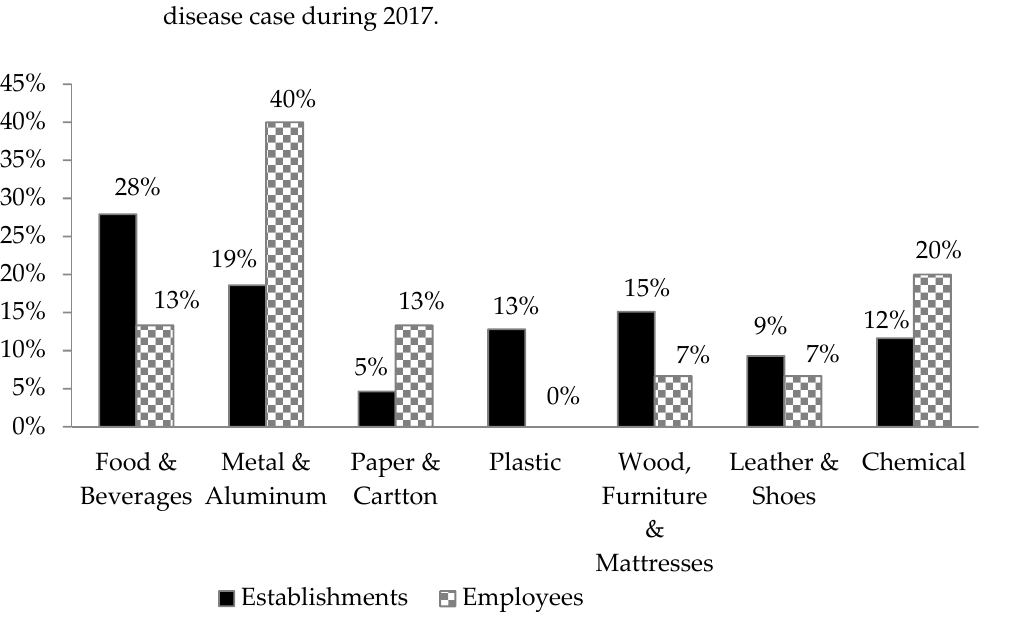
Figure 6. The OSH statistics in the industrial sectors between the years 2009 and 2016. Where: O.I = Occupational Injuries, O.A: Occupational Accidents, Occupational Diseases, and O.F: Occupational Fatalities.